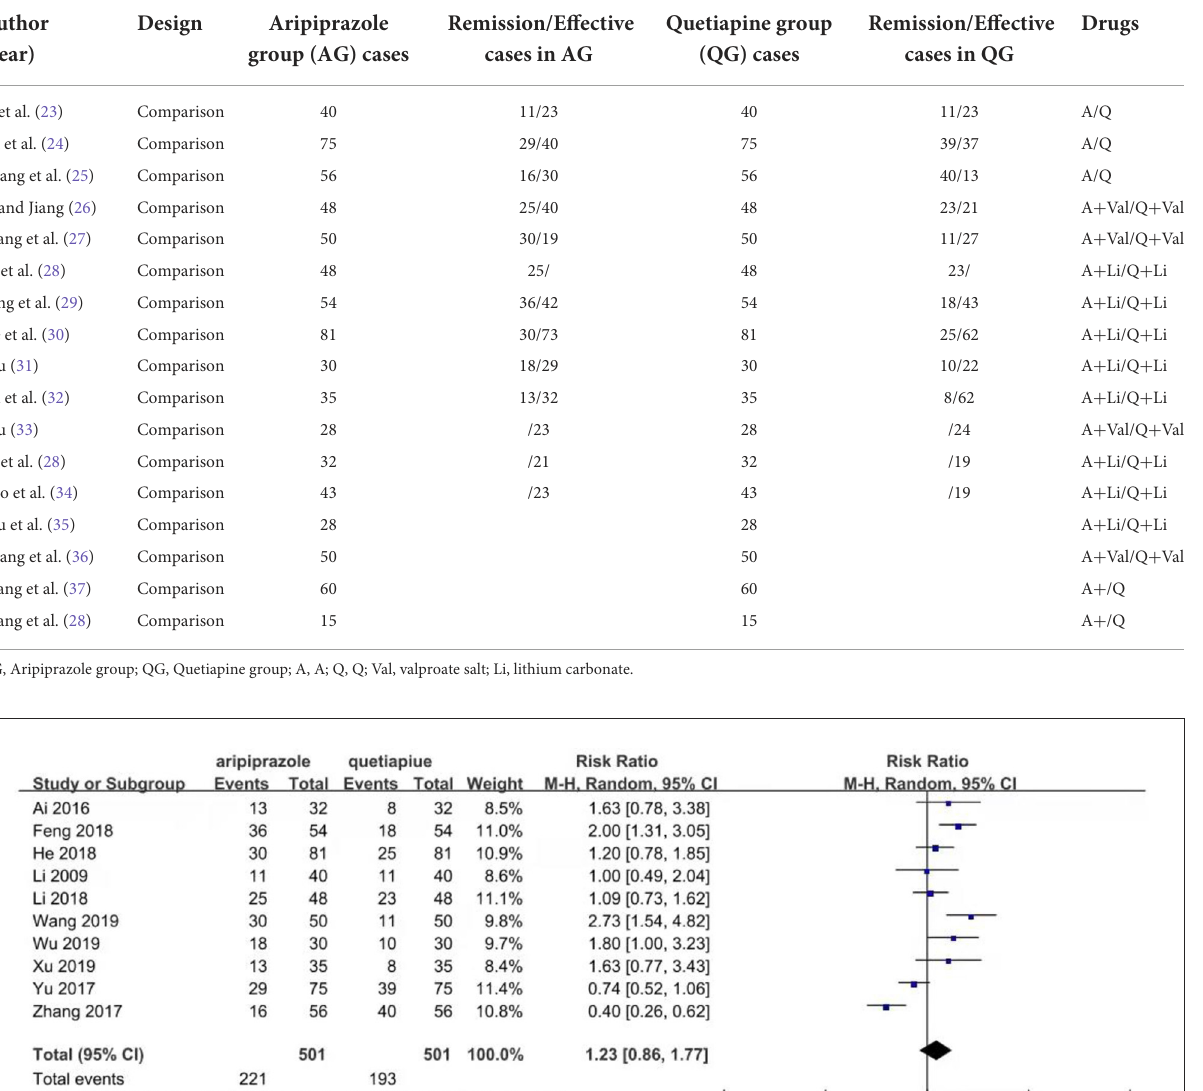
TABLE 1 Characteristics of studies included in the meta-analysis.